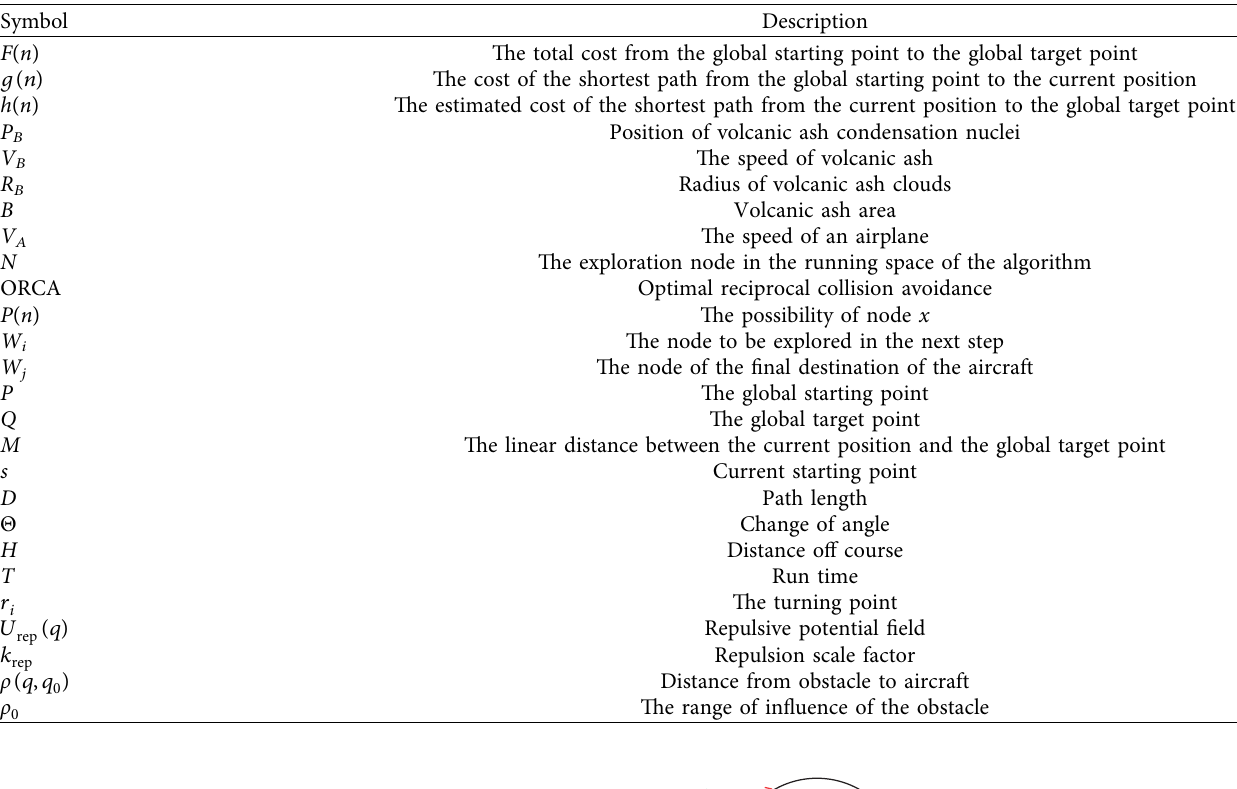
Table 1: Abbreviation table.